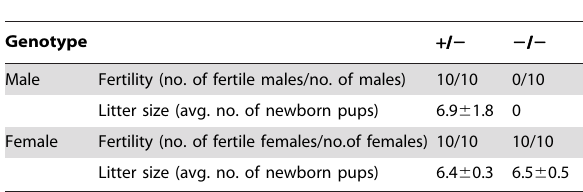
Table 1. Fertility rates among the mutant mice.